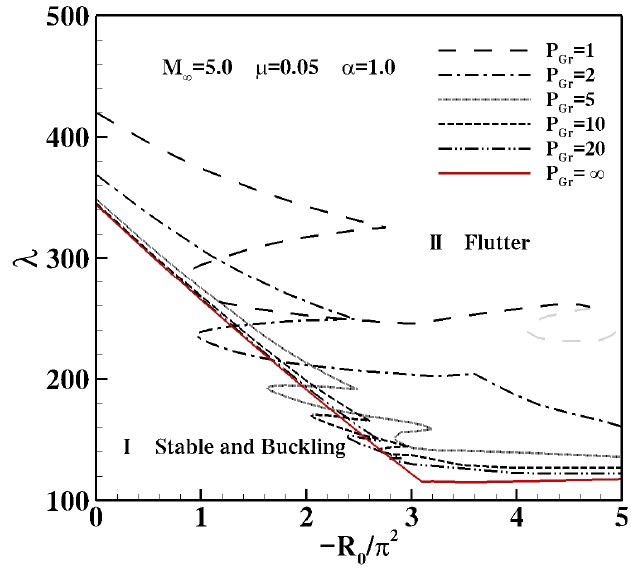
Figure 10. Stability regions under different pressure drop ratios.